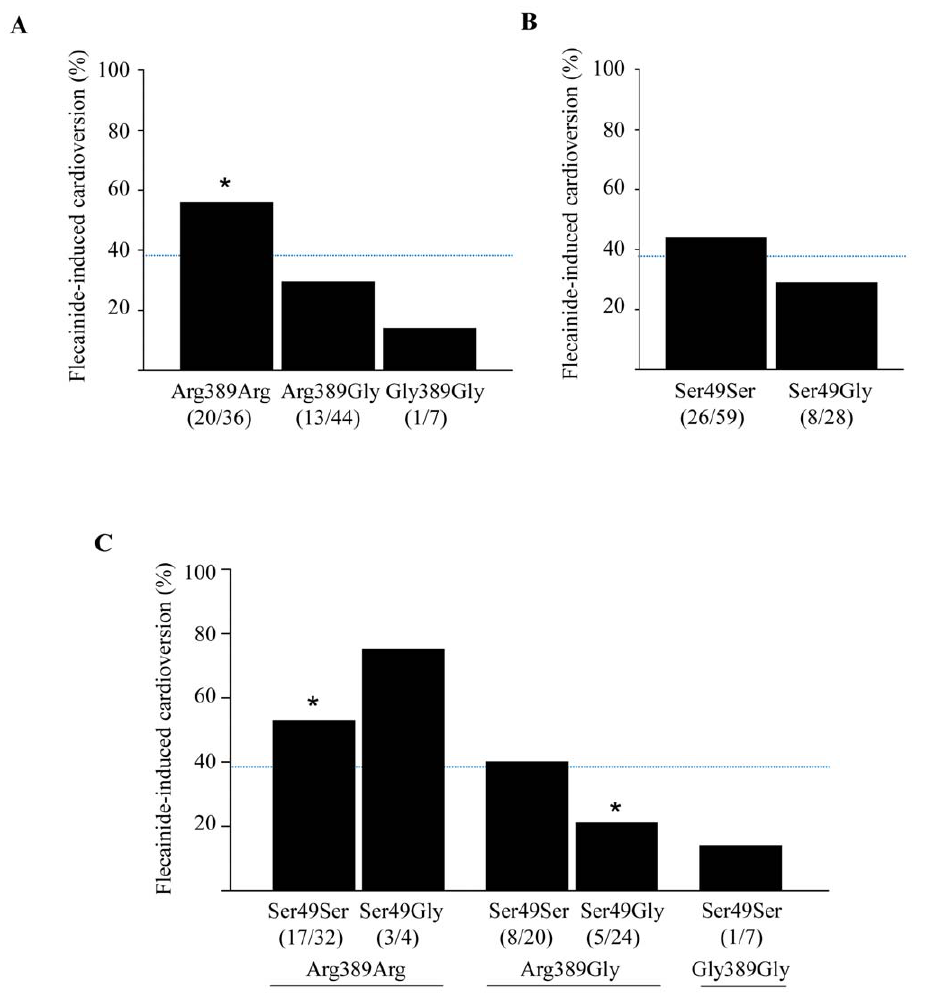
Figure 2. Success of flecainide-induced cardioversion in different b 1 AR genotypes, A, P389 polymorphism, B, P49 polymor- phism, C, combination genotype of P389 and P49 variants. Dashed line marks the average cardioversion rate of 39%. * p , 0.05 vs. other variants.